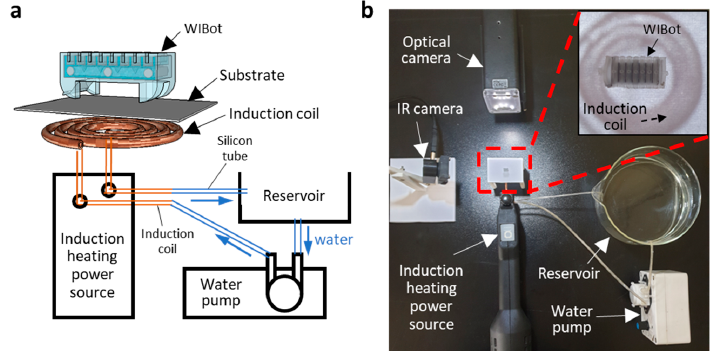
coil to prevent temperature increase. ( b ) Photograph of experimental setup with main components labeled. A coil with an inner diameter of 8 mm and an outer diameter of 16 mm was made of a 1-mm-thick copper tube. The inset shows a close-up image of the WIBot on